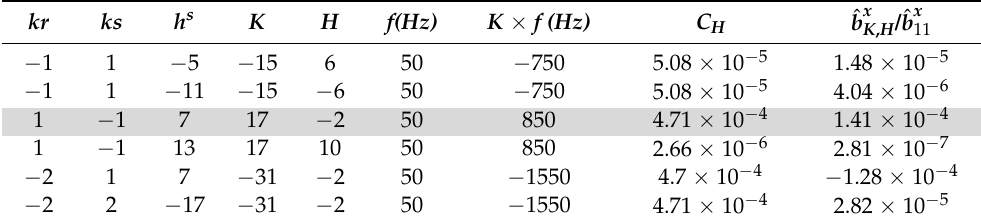
Table 1. Components generated by the healthy induction machine.